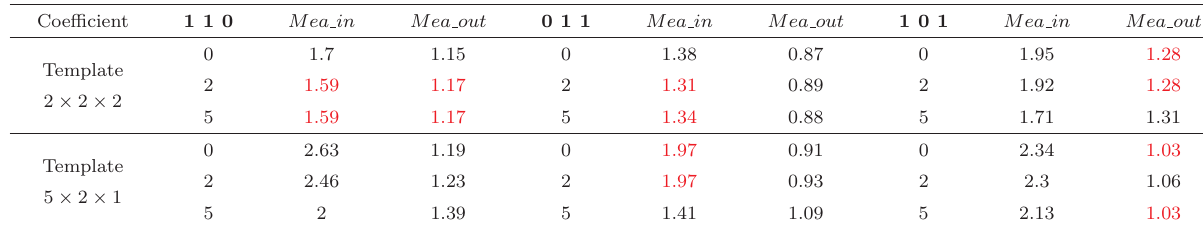
Table 2 Measurements of two items remaining experiment